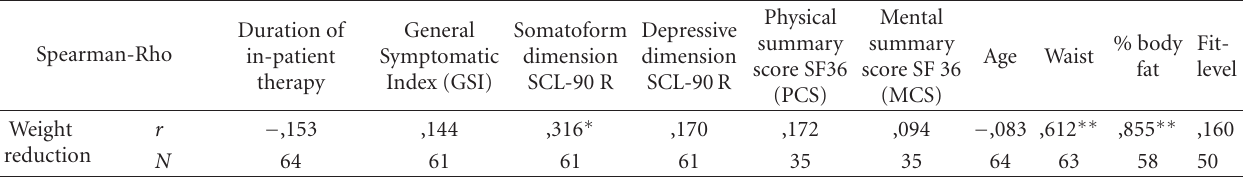
∗∗ Correlation is significant at P < 0,01 (two-tailed). ∗ Correlation is significant at P < 0,05 (two-tailed).